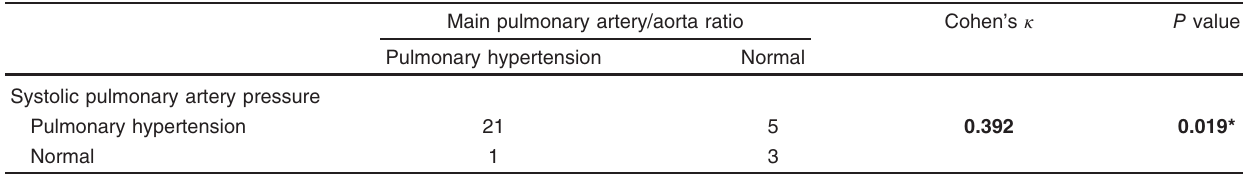
Table 5 Agreement between the main pulmonary artery/aorta ratio and systolic pulmonary artery